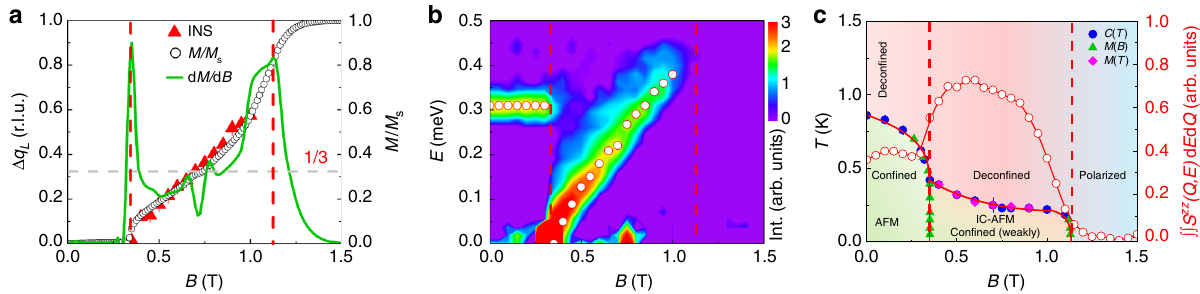
Fig. 6 Field-dependent magnetization and magnetic phase diagram of YbAlO 3 . a Field-dependent zero energy soft point at wave vector shift Δ q L = Q L − 1, extracted from the INS. Normalized magnetization M / M s , measured at 0.05 K, and the corresponding magnetic susceptibility d M /d B are over plotted. M s is the saturation moment for fi elds along the a -axis, and the horizontal dashed lines indicate the 1/3 magnetization plateau. b Field evolution of the energy- dependent inelastic neutron spectrum, at 0.05 K, integrated over wave vector H = [ − 0.1, 0.1] r.l.u., K = [ − 0.6, 0.2] r.l.u., L = [0.9, 1.1] r.l.u.. The empty circles indicate the peak positions. c The fi eld-temperature ( B − T ) magnetic phase diagram. The fi eld-dependent INS spectrum measured at 0.05 K is over plotted, which is integrated over H = [ − 0.1, 0.1] r.l.u., K = [ − 0.6, 0.2] r.l.u., L = [0, 2] r.l.u., and E = [0.05, 0.6] meV. The vertical dashed lines indicate